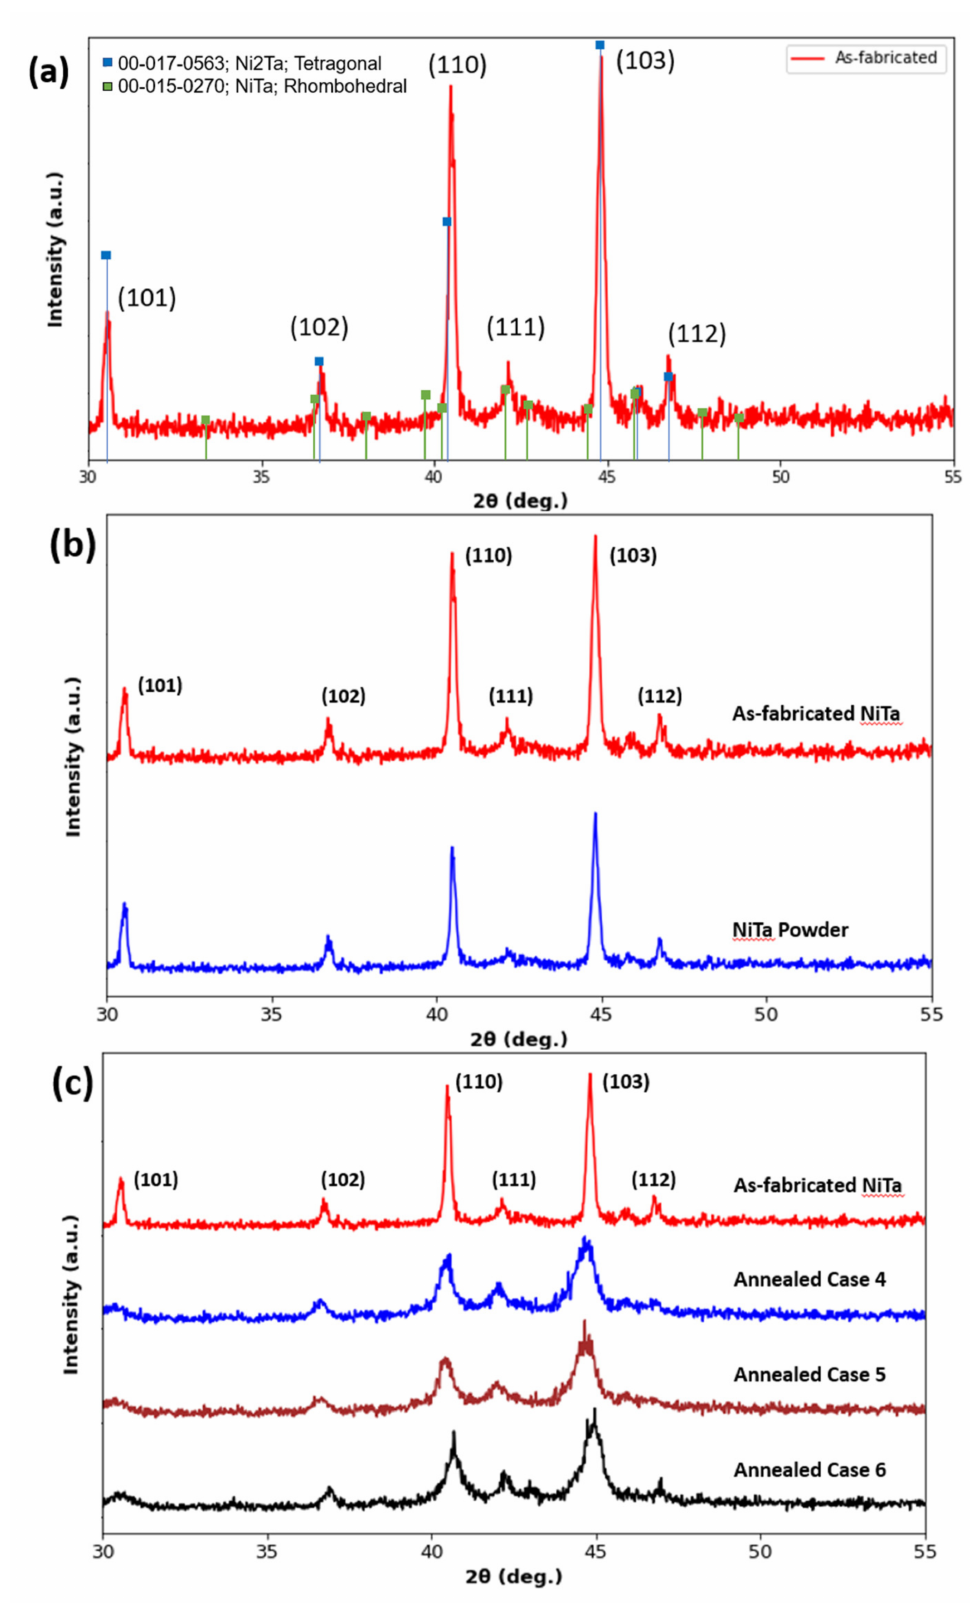
Figure 5. X-ray diffraction analysis for ( a ) as-fabricated, ( b ) as-fabricated and NiTa powder and ( c ) as-fabricated and annealed specimens (cases 4 to